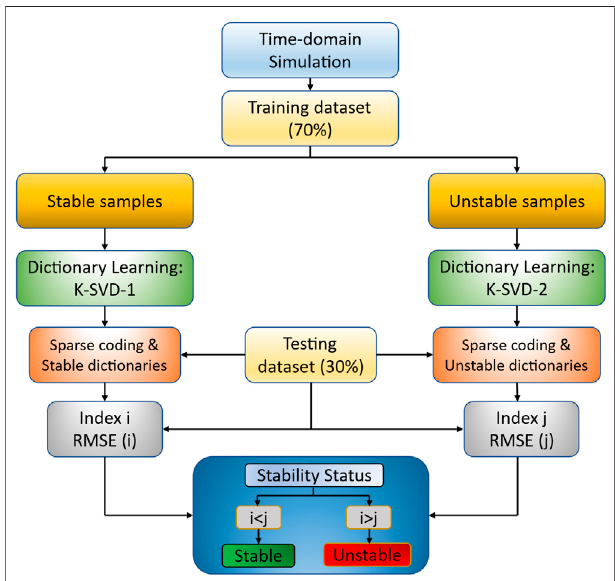
FIGURE 2 | Top – down philosophy of sparse dictionary learning – based TSA.